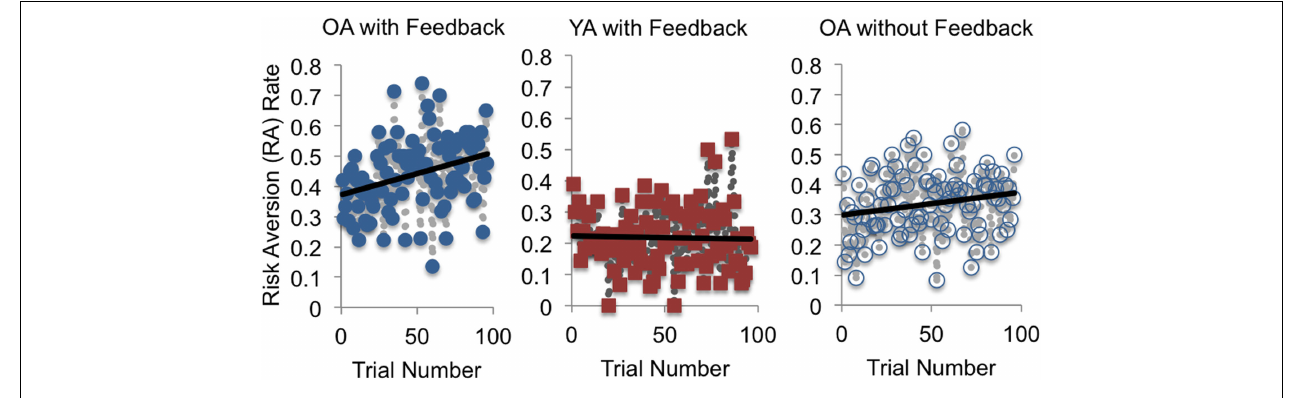
for OA under both feedback and no-feedback conditions implies that a passive process like goal neglect is a better explanation of the correlations than active interference by affective responses to negative